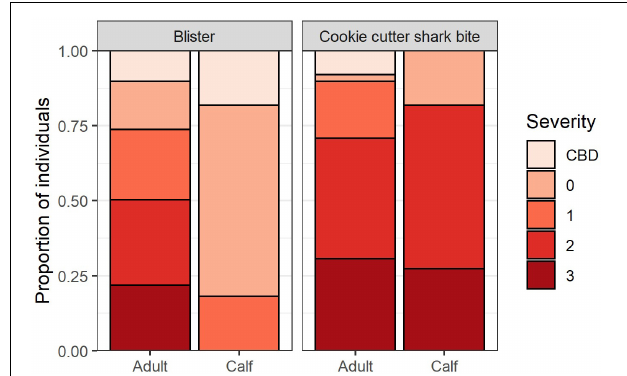
FIGURE 2 | Blister lesion and cookie cutter shark bite severity for adults ( n = 137) and calves ( n = 11). A score of 0 = no lesions present, 1 = mild, 2 = medium, 3 = severe, and CBD = severity could not be determined.